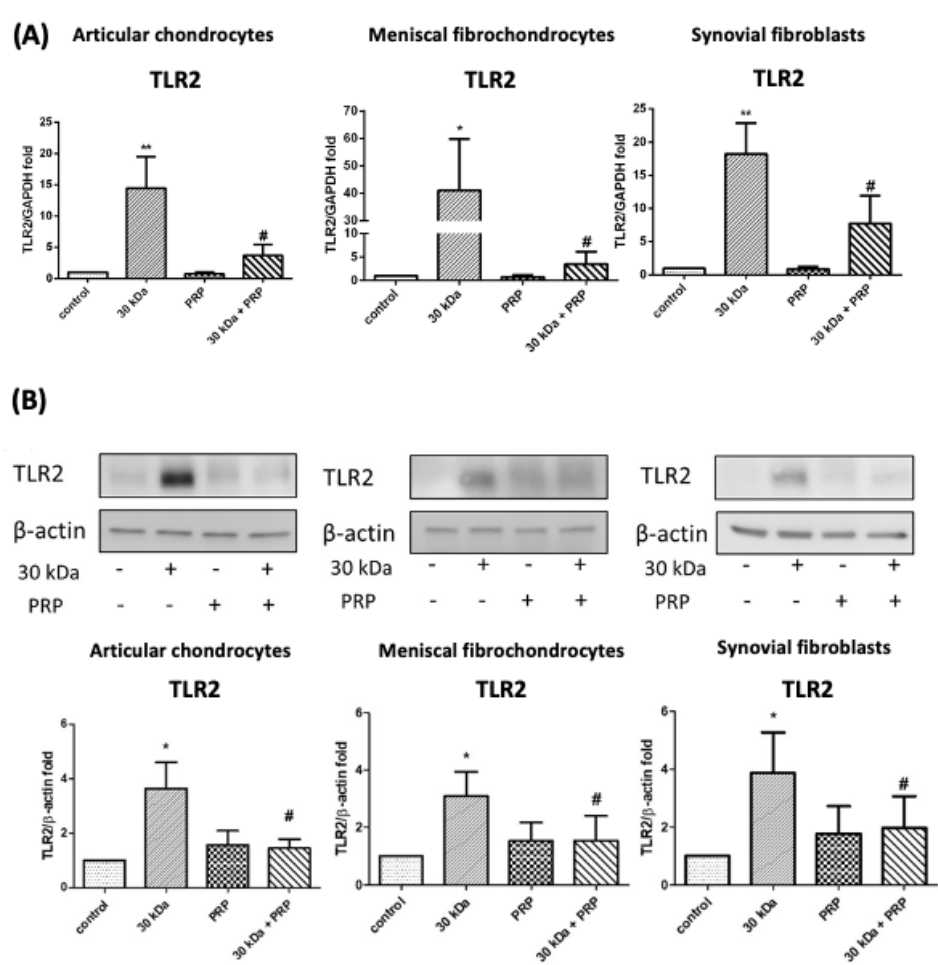
Figure 2. Effects of PRP on 30 kDa FN-f-induced TLR2 gene and protein expression in articular chondrocytes, meniscal fibrochondrocytes, and synovial fibroblasts. ( A ) PRP treatment significantly suppressed TLR2 gene upregulation induced by 30 kDa FN-f in all three type cells. (* p < 0.05, compared with control; ** p < 0.01, compared with control; # p < 0.05, 30 kDa + PRP vs. 30 kDa; n = 5 for each group). ( B ) PRP treatment significantly suppressed TLR2 protein upregulation induced by 30 kDa FN-f in all three type cells. Representative blots are presented in the upper panel, and semiquantitative data are presented in the lower panel. All data are presented as the mean ± SD. Statistical differences among TLR groups were compared with control values using the Student’s t -test (* p < 0.05, compared with control; ** p < 0.01, compared with control; # p < 0.05, 30 kDa + PRP vs. 30 kDa; n = 5 for each group).